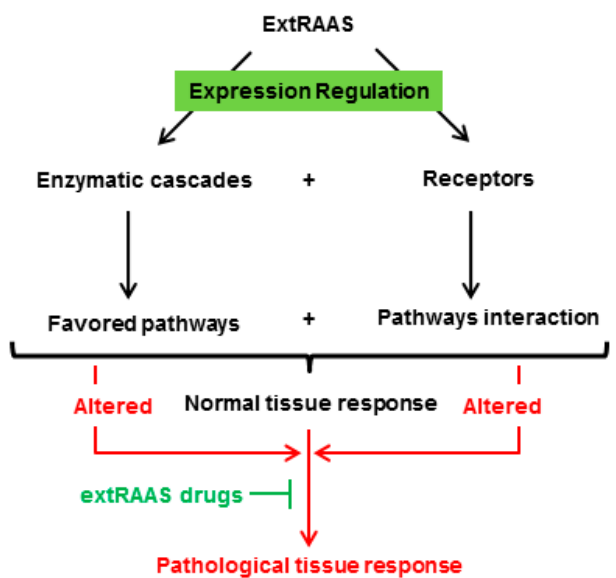
Figure 2. A specific combination of locally expressed RAS enzymes in a tissue results in the production of a specific combination of peptides that can bind to their corresponding receptors, leading to a locally balanced paracrine/autocrine effect that plays a role in tissue physiology and homeostasis. A change in local balance of RAS components will consequently lead to pathophysiological consequences.